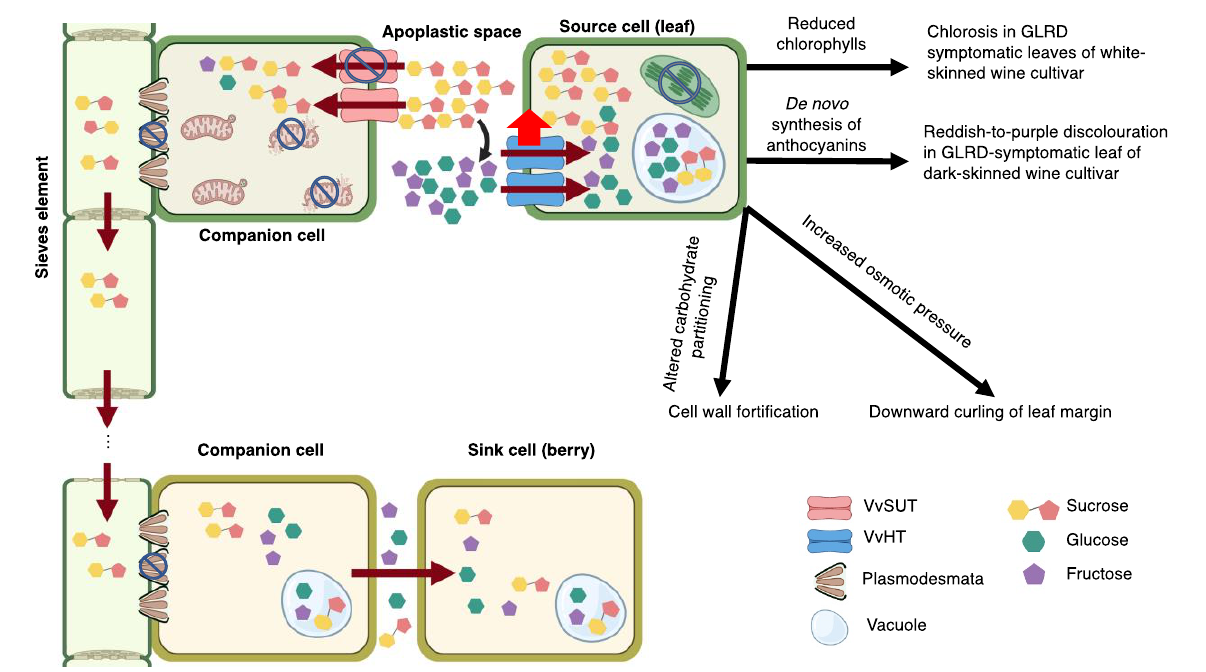
Figure 4. Working model on GLRaV-3-grapevine interactions leading to GLRD. GLRaV-3 replicates in association with the outer membrane of mitochondria, leading to mitochondrial damage and re- pressed ATP generation. VvSUT transports sucrose in an ATP-dependent manner. Loss of ATP in companion cells (CC) leads to down-regulated VvSUT activity, thereby, decreased sucrose import from apoplast to cytoplasm of CC. Increased sucrose accumulation in apoplast leads to increased hydrolysis of sucrose into glucose and fructose by acidic cell wall invertase (curved black arrow). Excess hexoses are then retrieved back into cells of source leaves via up-regulated VvHT. Consequently, photosynthesis in source cells was repressed as a result of negative feedback from excess sugar in source cells. This in turn leads to a decrease in chlorophyll biosynthesis and increase in chlorophyll degradation. Reduced chlorophylls lead to early onset of chlorosis in leaves of white-berried cultivars. Sugar accumulation in source cells leads to increased osmotic pressure, inducing downward curling of leaf margin. In addition, excessive sugar triggers alternative carbohydrate partitioning, including cell wall biosynthesis and biosynthesis of secondary metabolites, such as anthocyanins. De novo biosynthesis of anthocyanins leads to reddish-to-purple discolouration in GLRD-symptomatic leaf of dark-berried cultivar. GLRaV-3 infection may also trigger callose deposition around plasmodes- mata (PD), causing further blockage of sugar translocation between source and sink tissues. The net outcome is reduced uptake of sugar into the phloem and blockage of sugar translocation to the sink organ (berries), leading to smaller size and delayed maturation of a portion of the berries in a cluster. The degree of impact on berry cluster depends largely on the viral titer and the damage afflicted on the mitochondria. Note: cell organelles not discussed in the working model were omitted in the illustration figure. Created with https://BioRender.com (accessed on 10 March 2022). Publication license has been